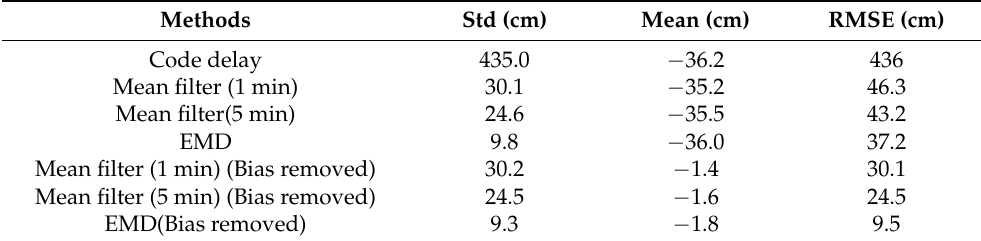
Table 1. The Std, Mean, and RMSE of the residuals between different methods and the in-situ SSH. Methods Std (cm) Mean (cm) RMSE (cm) Code delay